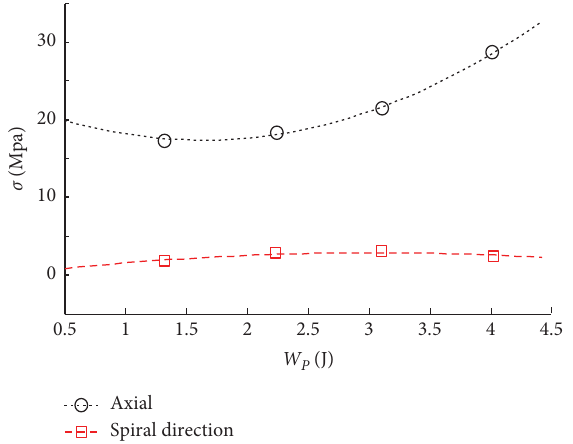
Figure 16: The impact stress transferred along the axial and spiral directions on the drilling